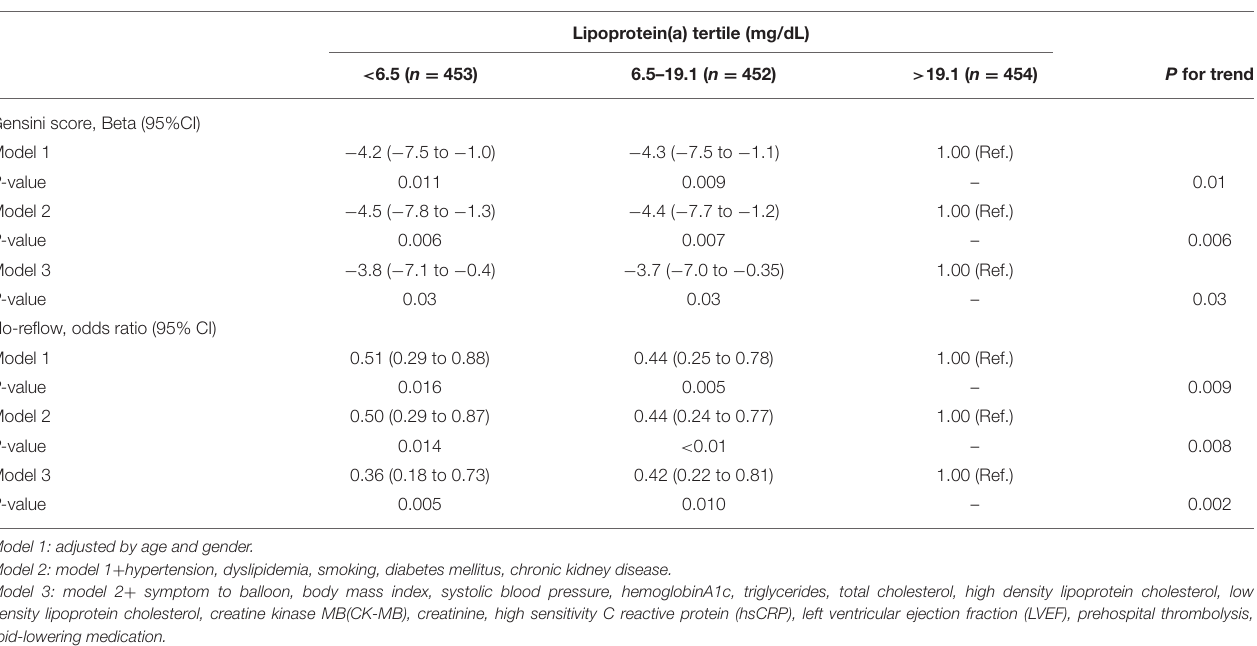
function, consistent with the analyses of protein levels. Hence,